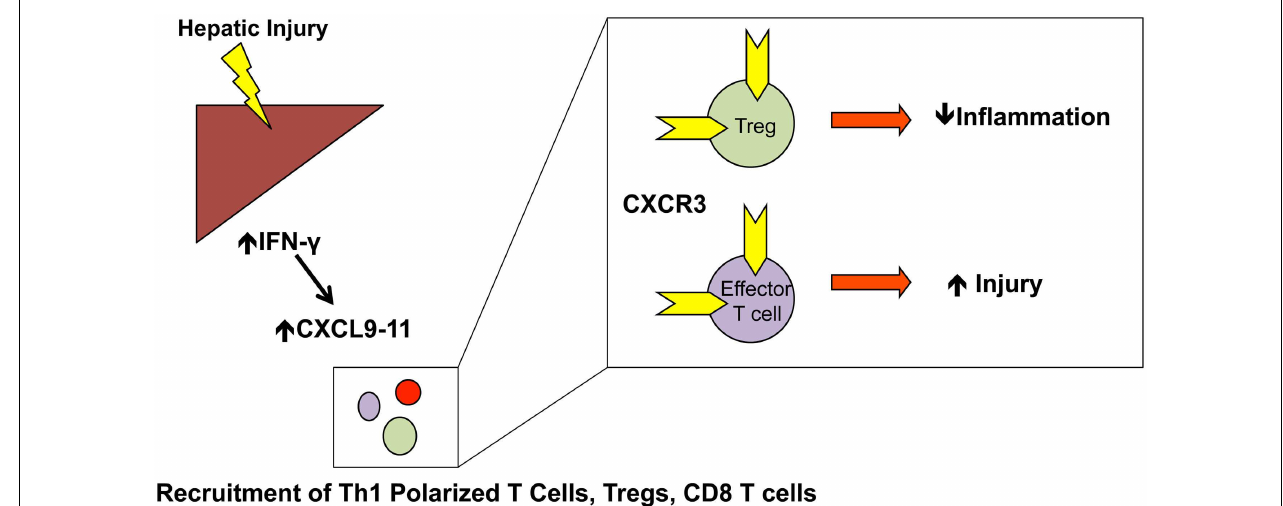
liver in a CXCR3-dependent manner.The specific type of injury will determine the relative recruitment ofTregs vs. effectorT cells and the protective/injurious role of the CXCL9–11/CXCR3